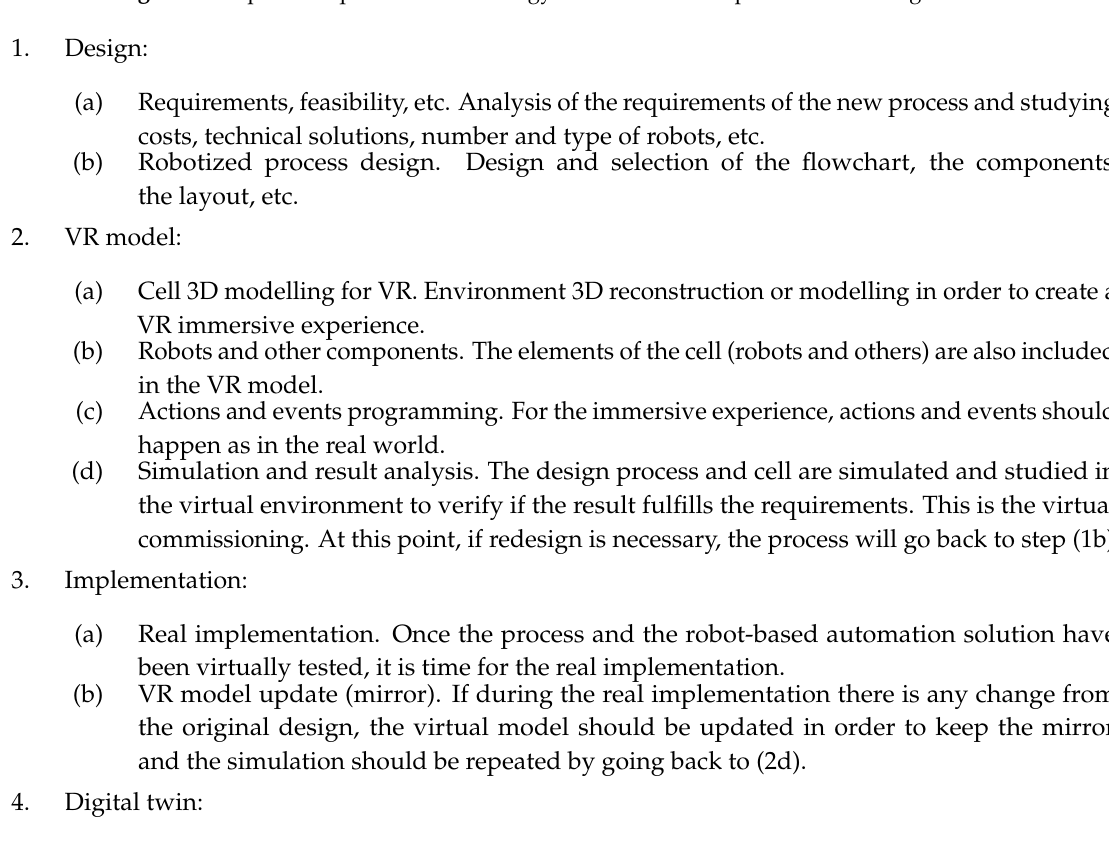
Figure 1. Proposed sequential methodology with feedback loops to create the digital